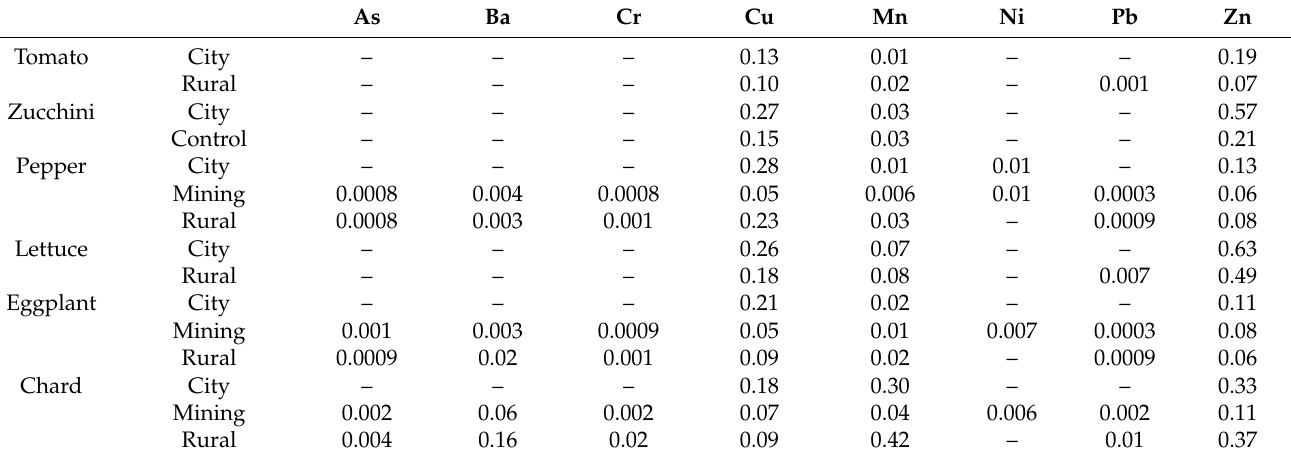
Table 4. Bioaccumulation coefficient ((BC) = C edible part/C soil) in the studied vegetable species collected in different urban